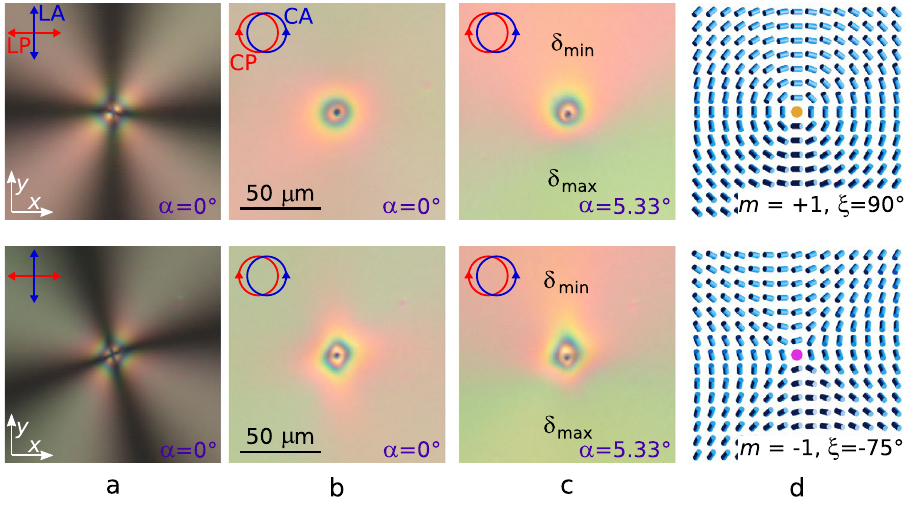
Figure 5. POM photos of nematic with boojums of strength m = + 1 and the phase ξ d / 2 = 90 ◦ (the first row), m = − 1 and ξ d / 2 = 75 ◦ (the second row). The photos were taken in the crossed linear polariser (LP) and analyser (LA) at the polariser orientation 0 ◦ ( a ), in the crossed circular polariser (CP) and analyser (CA) at the angles α = 0 ◦ ( b ) and α = 5.33 ◦ ( c ). The appropriate director orientations on the top substrate calculated by Eq. (7) ( d